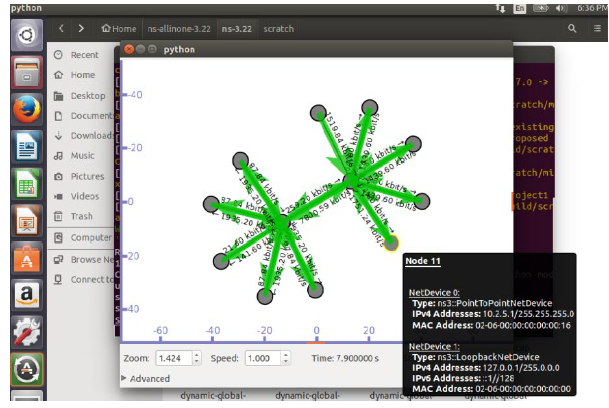
Figure 4. Sensor-Node position in simulation. The set-up and steadystate stage ie., Cluster Formation, CH election and Data transmission securely in modern- Secure-WSN are shown in figures 5,6 and